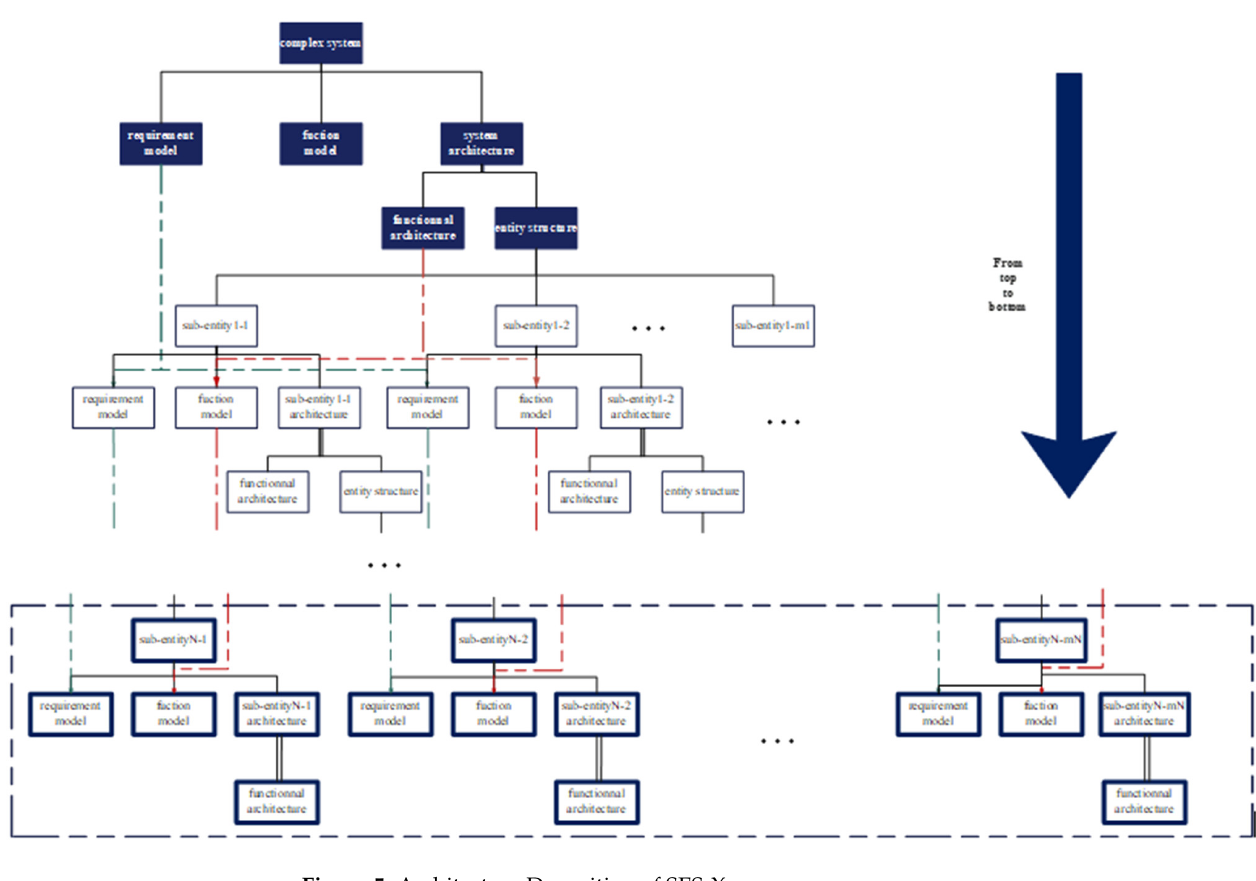
Figure 5. Architecture Deposition of SES-X.